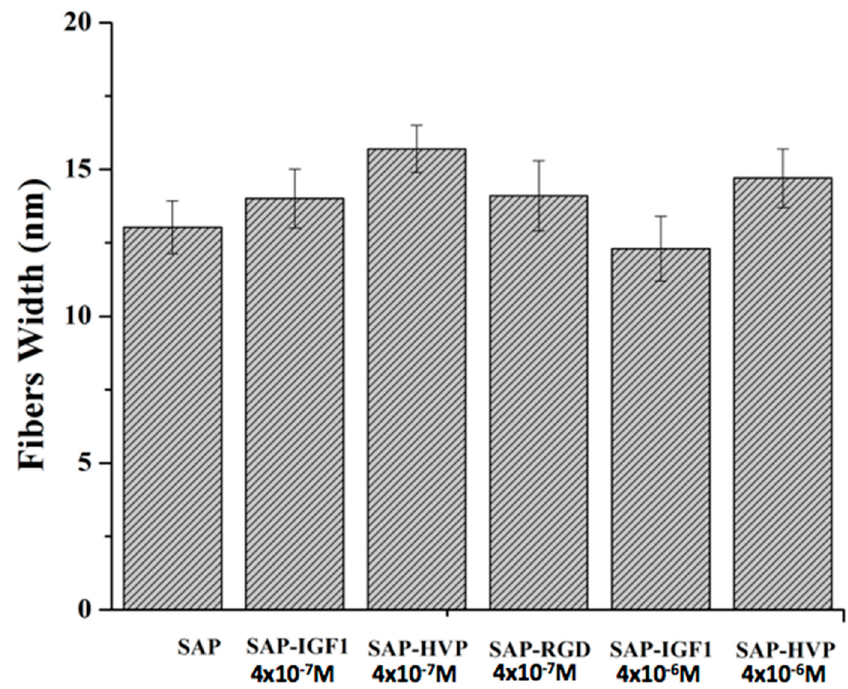
Figure 4. Fibers width of Self-Assembling Peptide (SAP) hydrogels and decorated SAP hydrogels at different concentrations.